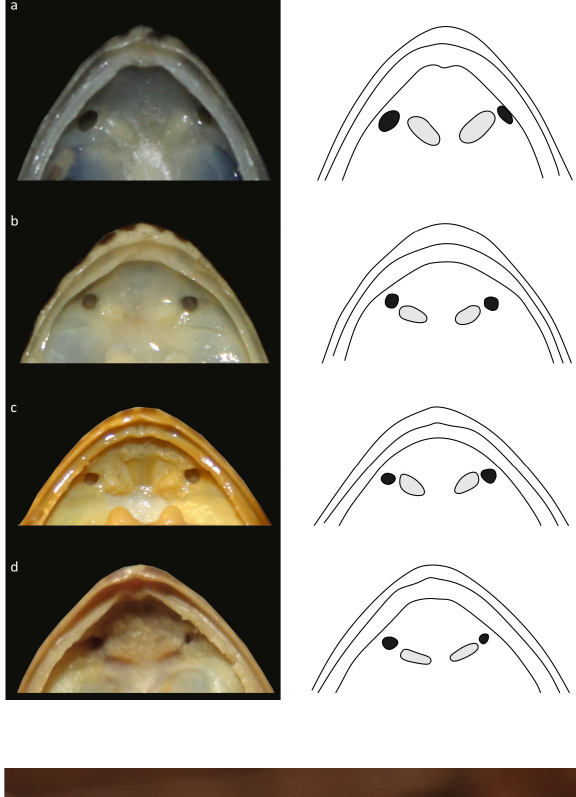
Image 4. Indirana salelkari sp. nov. in life (female paratype, AGCZRL-amphibia-210, 30.9mm